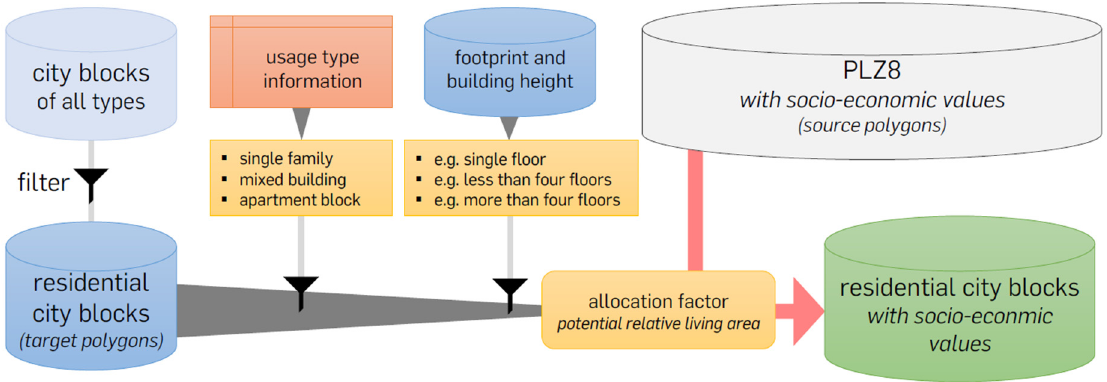
Figure 5. Schematic flow chart of the disaggregation process (source: authors).